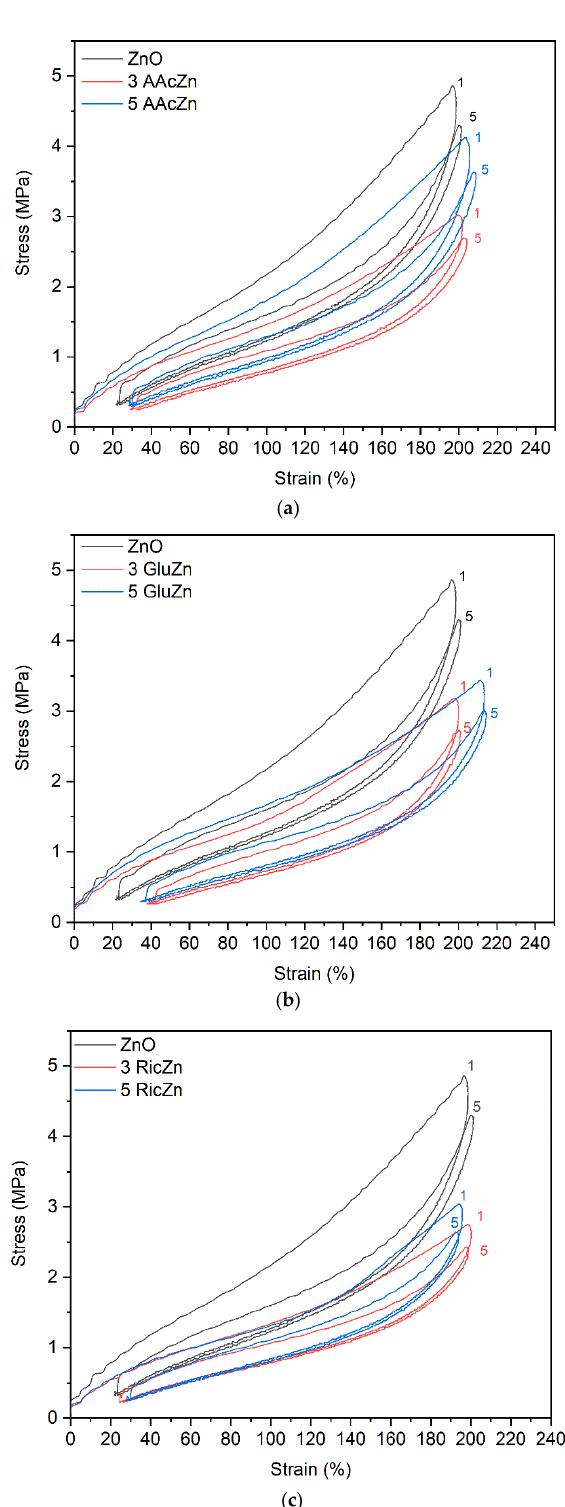
Figure 4. Stress–strain cyclic loading–unloading curves of SBR vulcanizates with varying activators: 1, 5—first and fifth loading–unloading cycle, respectively: ( a ) AAcZn, ( b ) GluZn, ( c ) RicZn. Table 5. Permanent set of SBR vulcanizates (standard deviation ±2%).